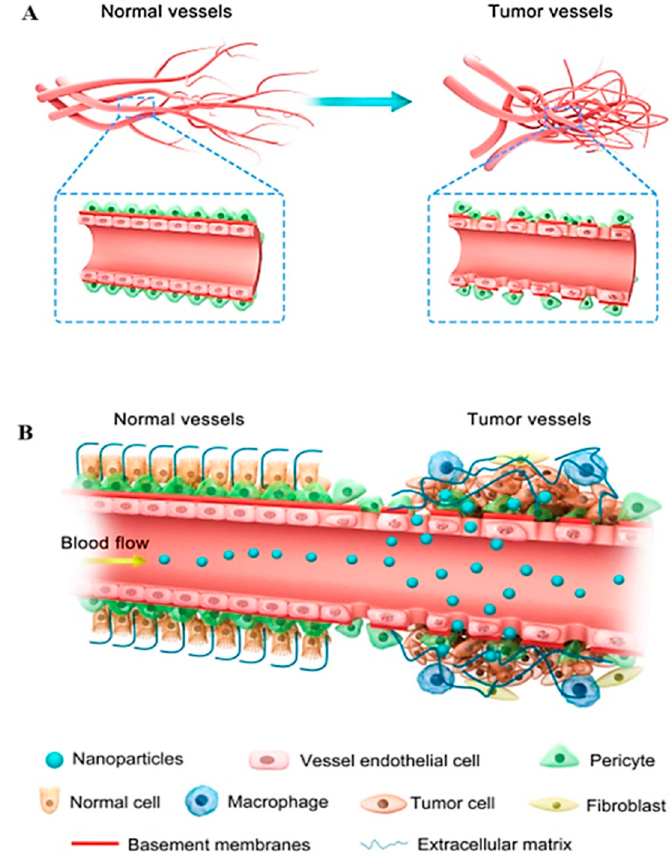
Figure 5. ( A ) illustrates the vasculature of both normal and tumor cells and ( B ) shows accumulation and penetration of NPs in tumor tissues via EPR effect. Reproduced from